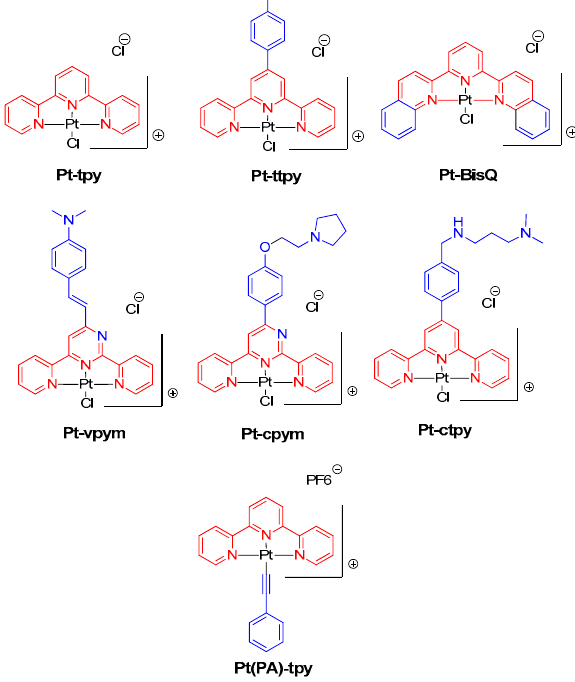
Scheme 1. The panel of metal complexes used in this study.